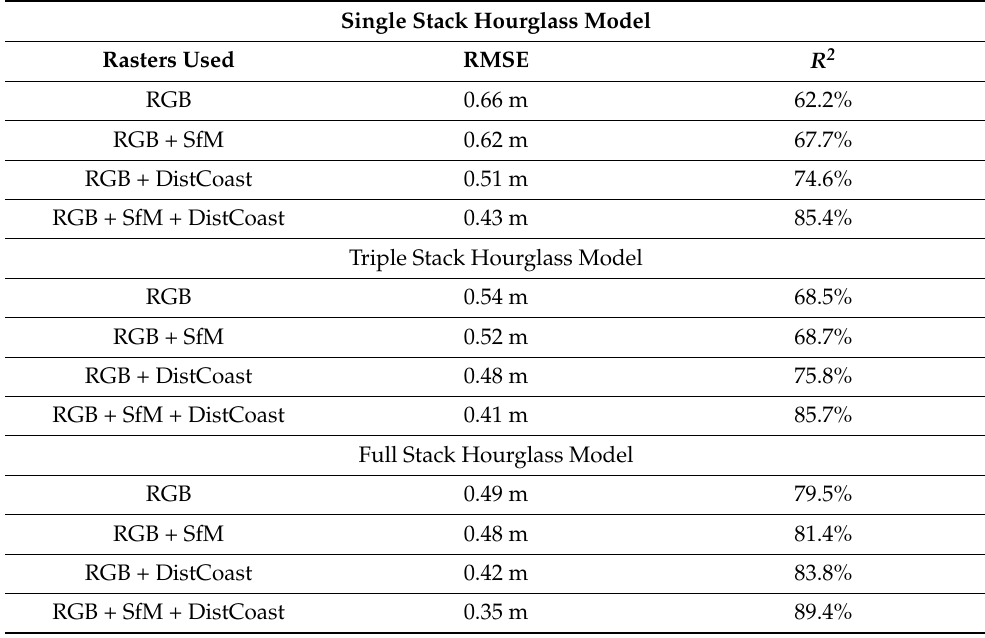
Table 2. Ablation test results using single and full stack modes for evaluating the optimal combination of raster inputs and the advantages of full stack compared to single